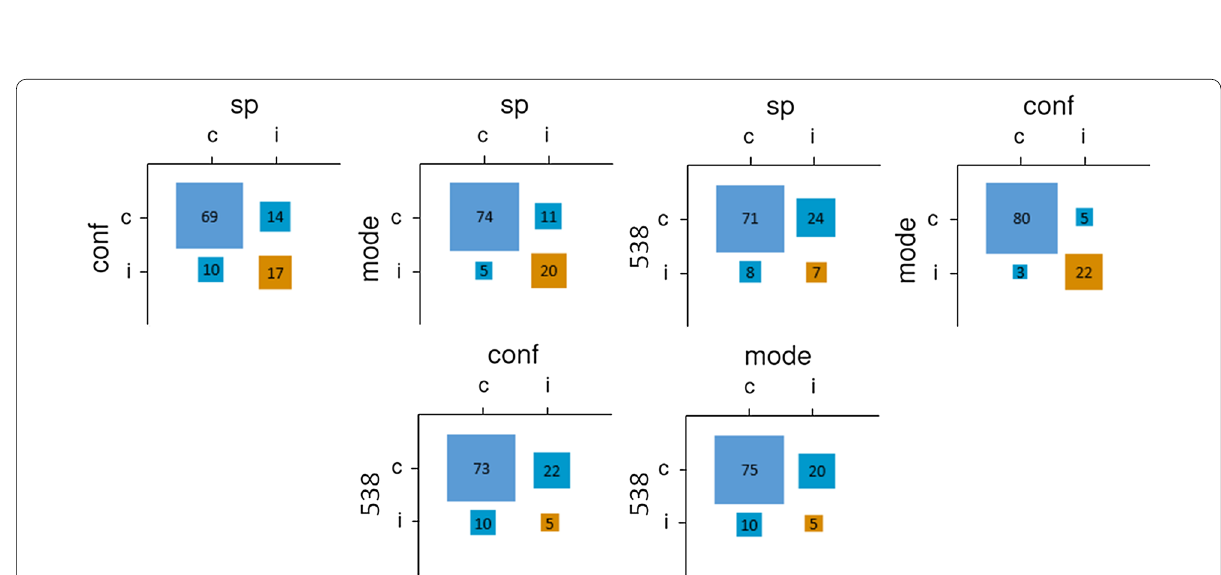
Fig. 3 Relationships between pairs of prediction methods for Study 2 (total sample). Note sp mode democratic; 538 fivethirtyeight.com = =